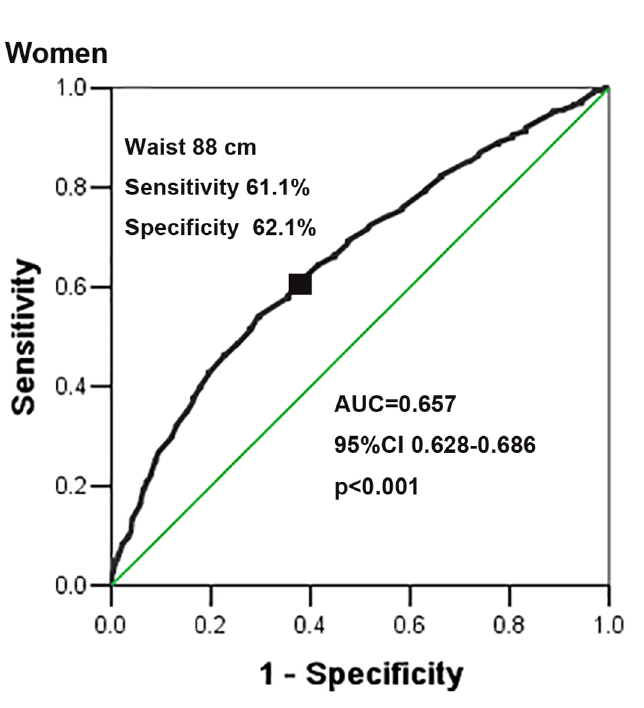
Fig 3. ROC curve of waist circumference to detect the existence of at least two other components of MetS in Kazakhs based on the JIS (2009) in